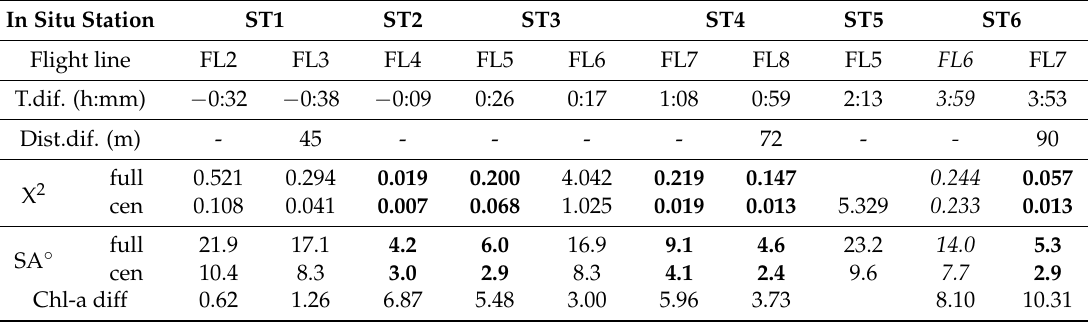
Table 2. Chi-squared (X 2 ) and spectral angle (SA) metrics and Chl-a retrieval difference for all 10 matchups between in situ and image R w . T.diff: time difference between in situ measurement and aircraft overpass; negative time means that in situ measurement is done before, and positive after, the airborne measurement. Dist.dif: distance between in situ and image measurement